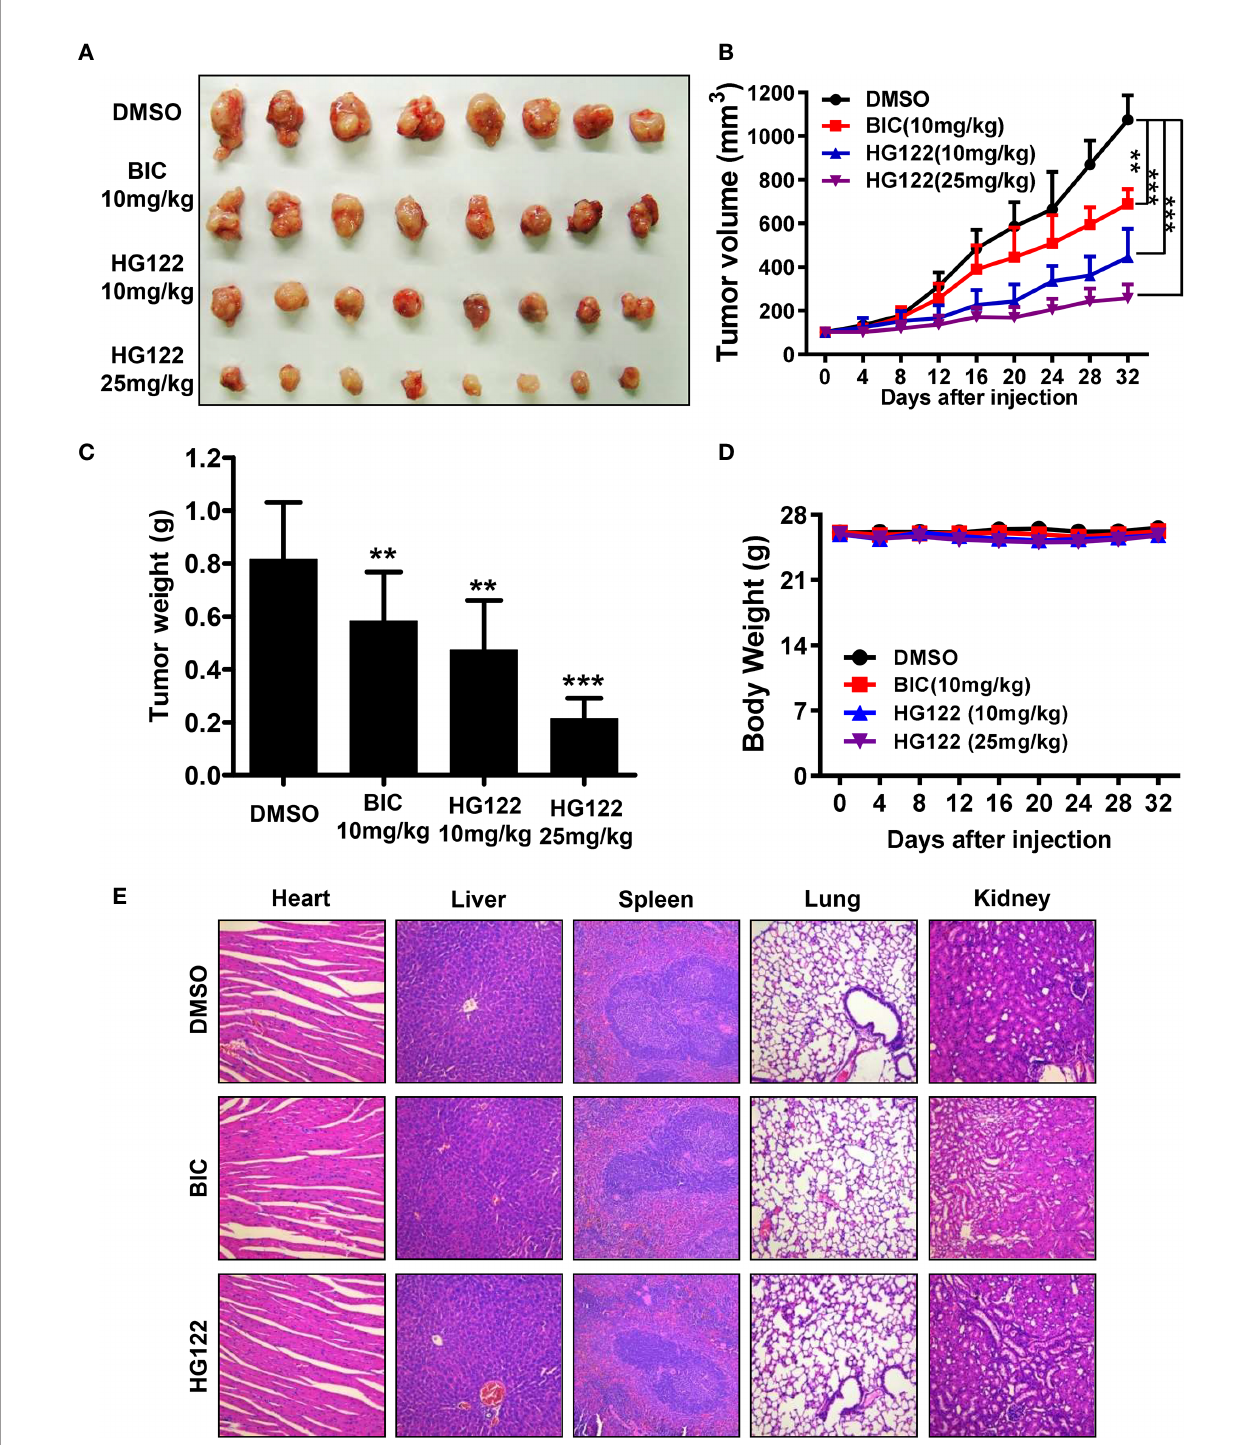
FIGURE 5 | Therapeutic effects of HG122 on subdermal model. (A) 22RV1 tumor-bearing nude mice were treated with HG122 at 10 and 25 mg/kg/d, BIC at 10 mg/kg/d or with vehicle. Compared to the vehicle group, HG122- and BIC-treated group showed inhibition of tumor growth. (B) Tumor volumes were measured twice per week, and treatment with HG122 resulted in signi fi cant inhibition of tumor volume compared to treatment with the vehicle control. (C) Tumor weights were measured. (D) HG122 did not cause obvious changes in body weight in the vehicle and HG122-treated groups. (E) HG122 (25 mg/kg/d) did not cause obvious pathological abnormalities in normal tissues. H&E staining of paraf fi n-embedded sections of the liver, spleen, kidney, heart, and lung (n = 8, **, P < 0.01; ***, P <